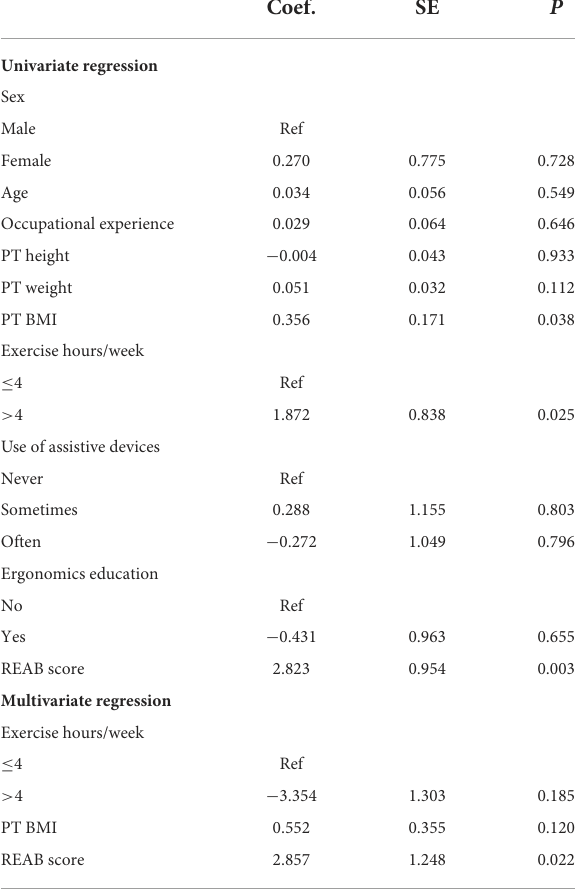
TABLE 5 Coefficient estimates obtained from univariate and multivariate logistic regression predicting musculoskeletal discomfort.